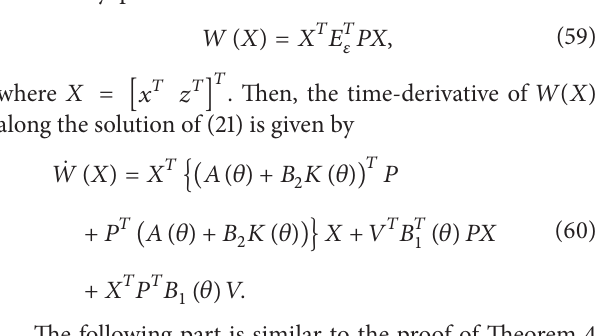
Table 1: Parameters of wind